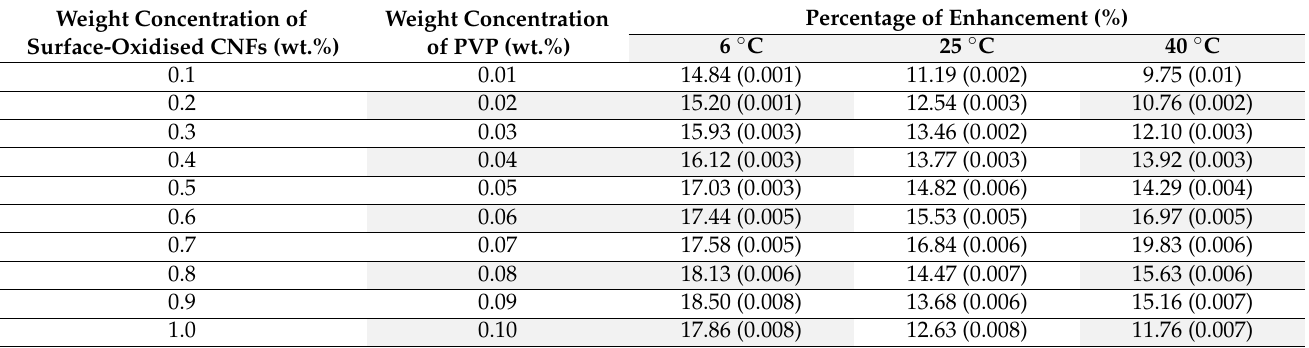
Table 8. Thermal conductivity enhancement of the surface ‐ oxidised CNF ‐ based nanofluids with PVP. Weight Concentration of Surface ‐ Oxidised CNFs Weight Concentration of PVP